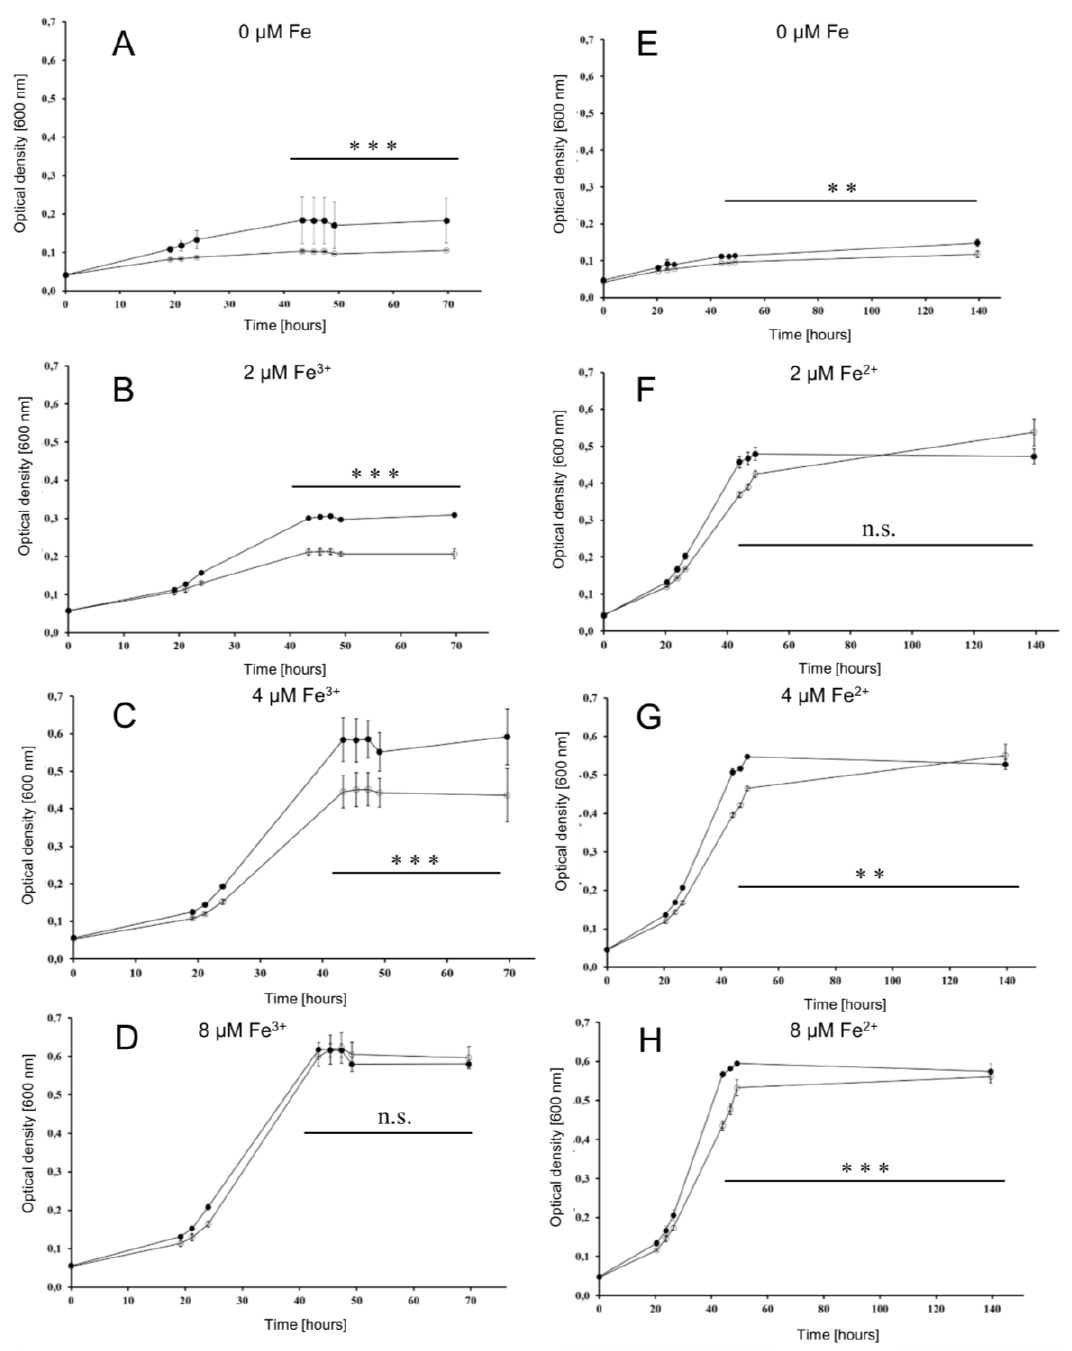
Figure 4. Growth curves of the wild type (filled symbols) and the iuc gene deletion mutant (open symbols) in the absence of iron and at three di ff erent iron concentrations, as indicated. Growth with Fe 3 + is shown to the left ( A – D ), and growth with Fe 2 + is shown to the right ( E – H ). Results of three biological replicates and their standard deviations are shown. The OD 600 values at the last five time points were used to evaluate the significance of the di ff erence between the wild type and iuc deletion mutant using an unpaired Student’s t -test (ns = non-significant; ** p < 0.01; *** p <